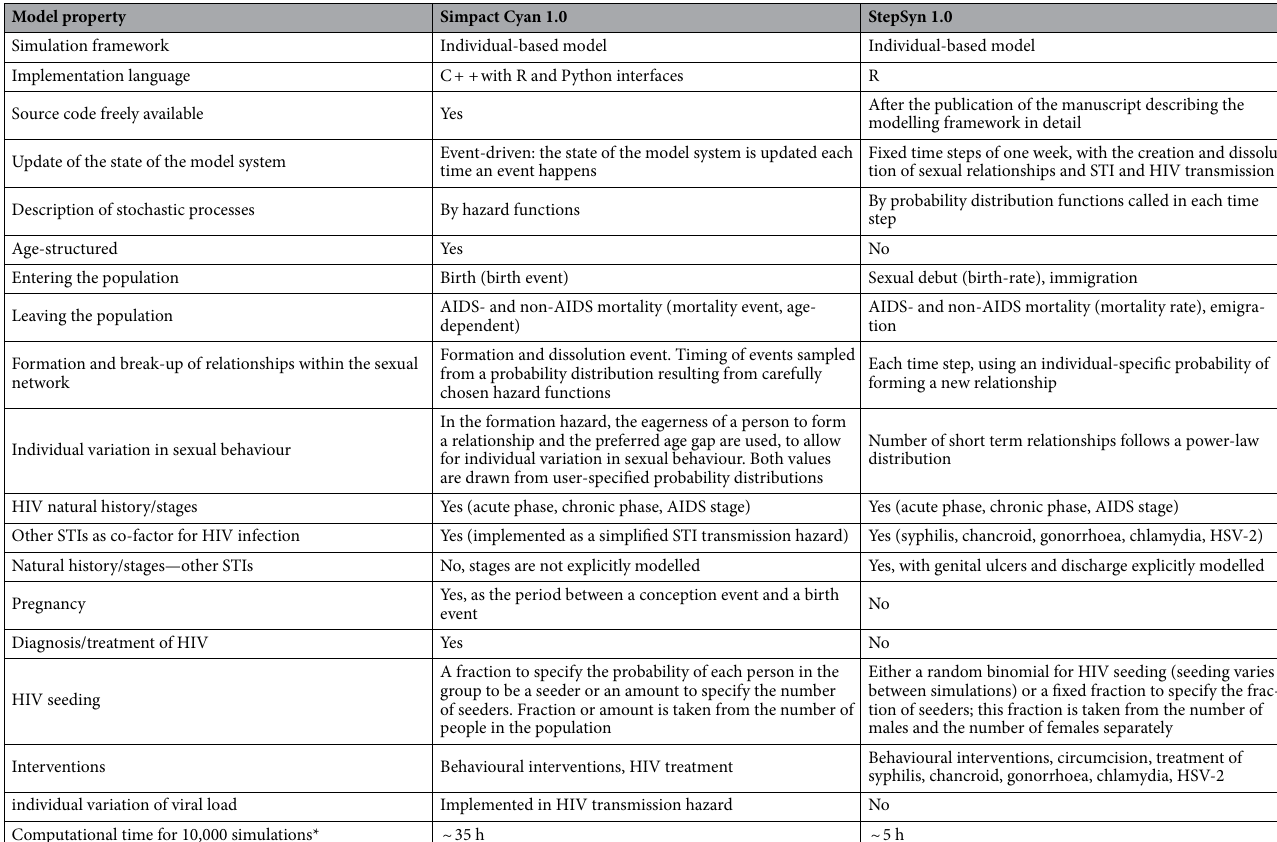
Table 1. Comparison of properties of models developed with Simpact Cyan 1.0 and StepSyn 1.0. *On 100 cores of the VSC (Xeon E5-2680v2 CPUs 2.8 GHz, 25 MB level 3 cache). Population size ~ 9000; time frame of the simulation = 35 years; parameters: see Table S10 (Simpact Cyan 1.0 basic model) and S14 (StepSyn 1.0 basic